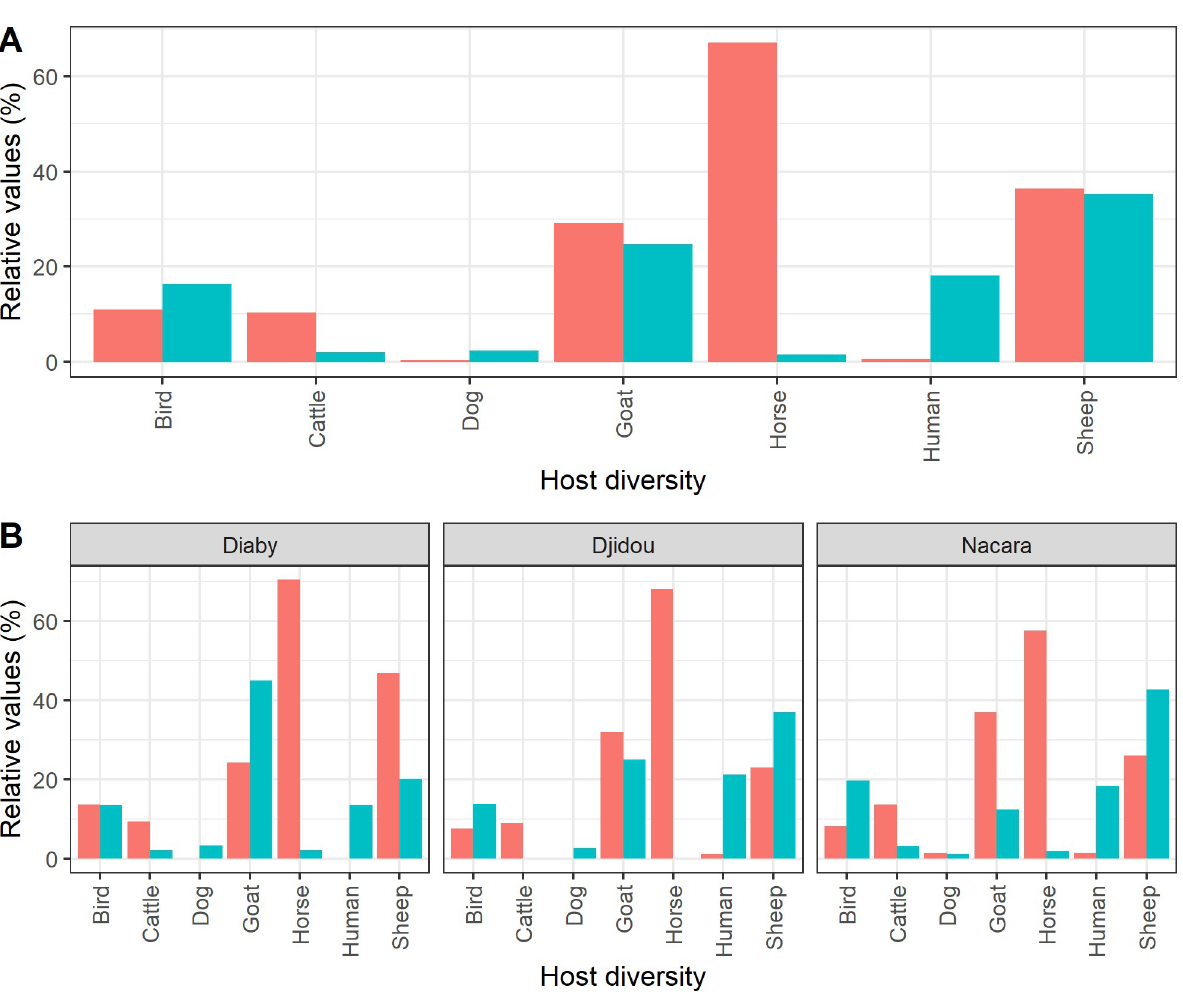
Fig 2. Origin of blood meals (relative values) taken by Ae . vexans arabiensis females collected at different sites (in pink) and vertebrate host proportions around trapping site (in cyan blue). (A) represents the compiled frequencies of all study sites and (B) represents the corresponding frequencies according to study sites.